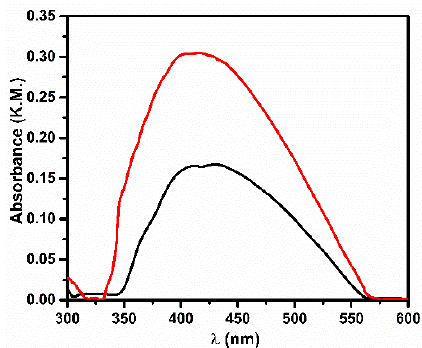
Figure 1. UV-Vis extinction spectra (Kubelka–Munk units) of SiO 2 -Ag before (black line) and after (red line) the 366 nm radiation.